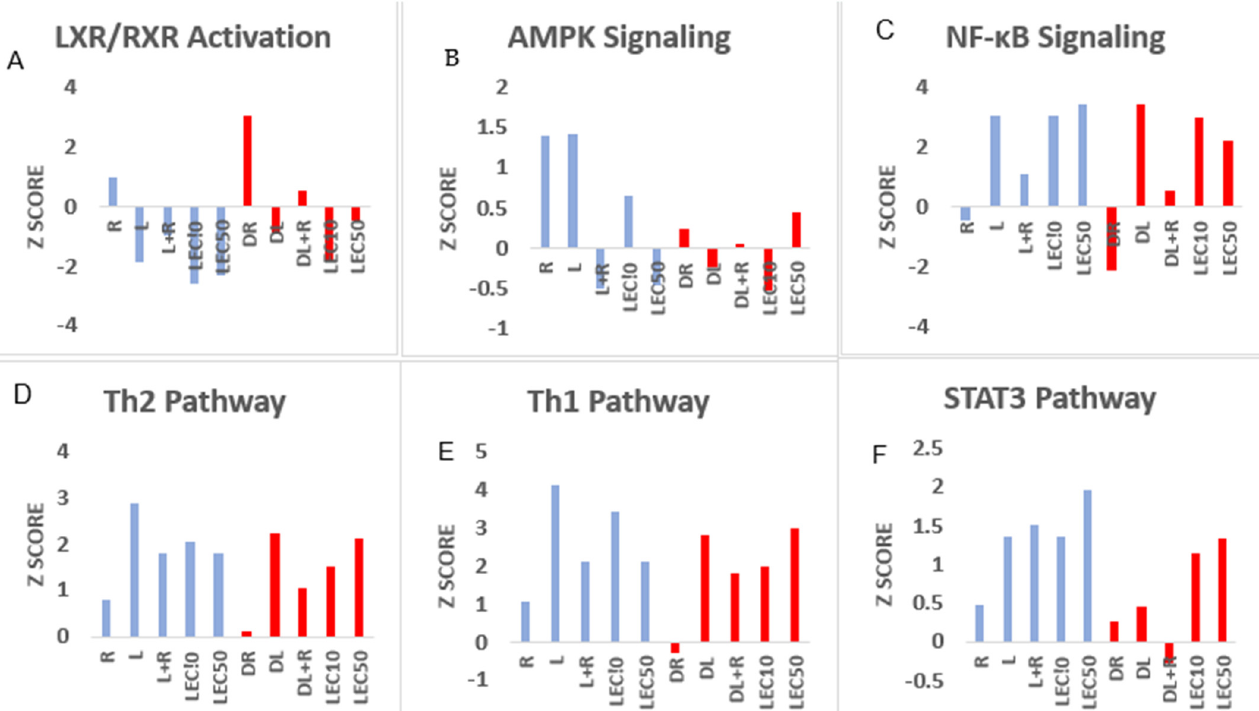
Figure 2. The role of RES, LPS, LPS + RES, LEC10, LEC50, on gene expression of mediators involved in signaling pathways in PBMCs from non-diabetic controls and PwD2. Human PBMCs from controls and PwD2 were treated and compared with the vehicle control for 3 h. RNA was extracted from the cells and analyzed using RNAseq. These data were first extracted using the DEG analysis, followed by ingenuity pathways analysis. Z scores are plotted against the signaling pathways.